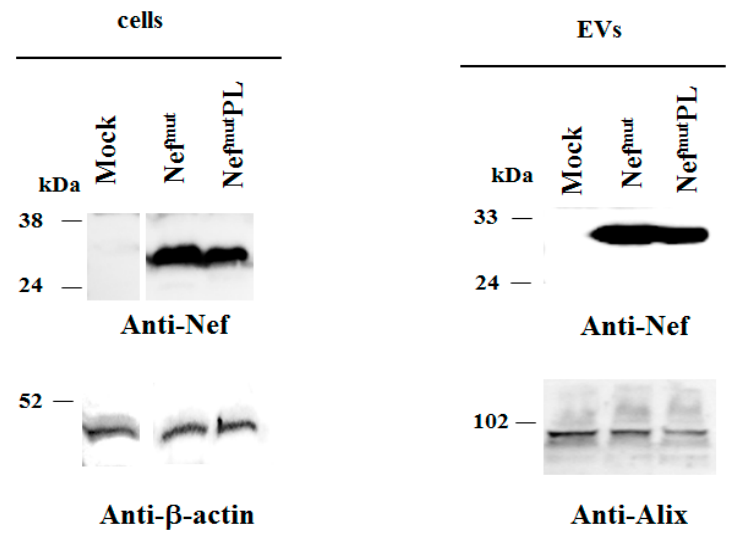
Figure 2. Detection of Nef mut PL in transfected cells and EVs. Western blot analysis on 30 µ g of lysates of HEK293T cells transfected with DNA vectors expressing either Nef mut or Nef mut PL (left panels). Equal volumes of the buffer where purified EVs were resuspended after differential centrifugations of the respective supernatants were also analyzed (right panels). As controls, both cell and EV lysates from mock-transfected cells were included. Polyclonal anti-Nef Abs served to detect Nef mut -based products, while β -actin and Alix were revealed as markers for cell lysates and EVs, respectively. Molecular markers are given in kilodaltons (kDa). The results are representative of seven independent experiments.